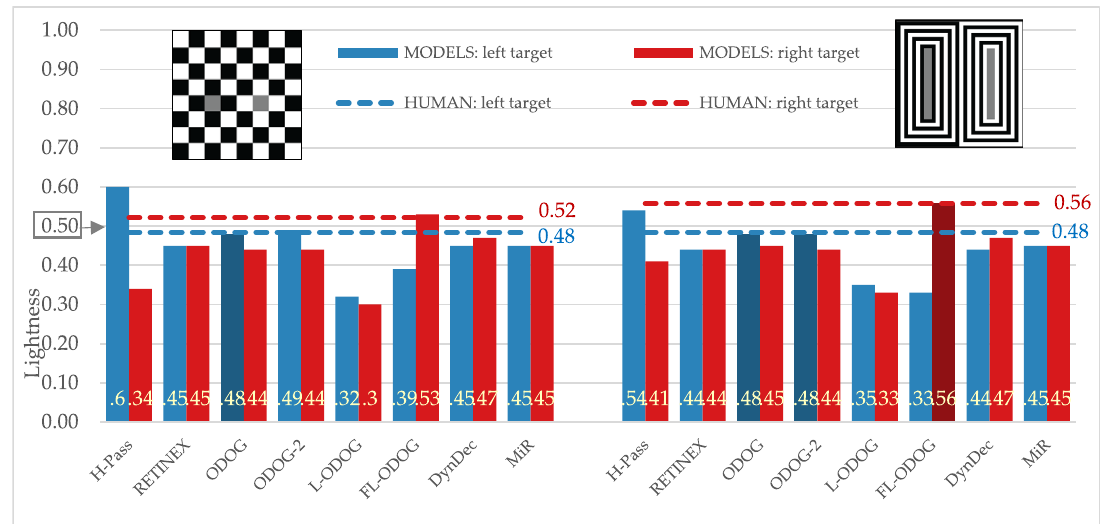
Figure 10. Empirical and model results for Checkerboard and Bullseye illusions. The target lightness value is marked at 0.5 on the Y axis.